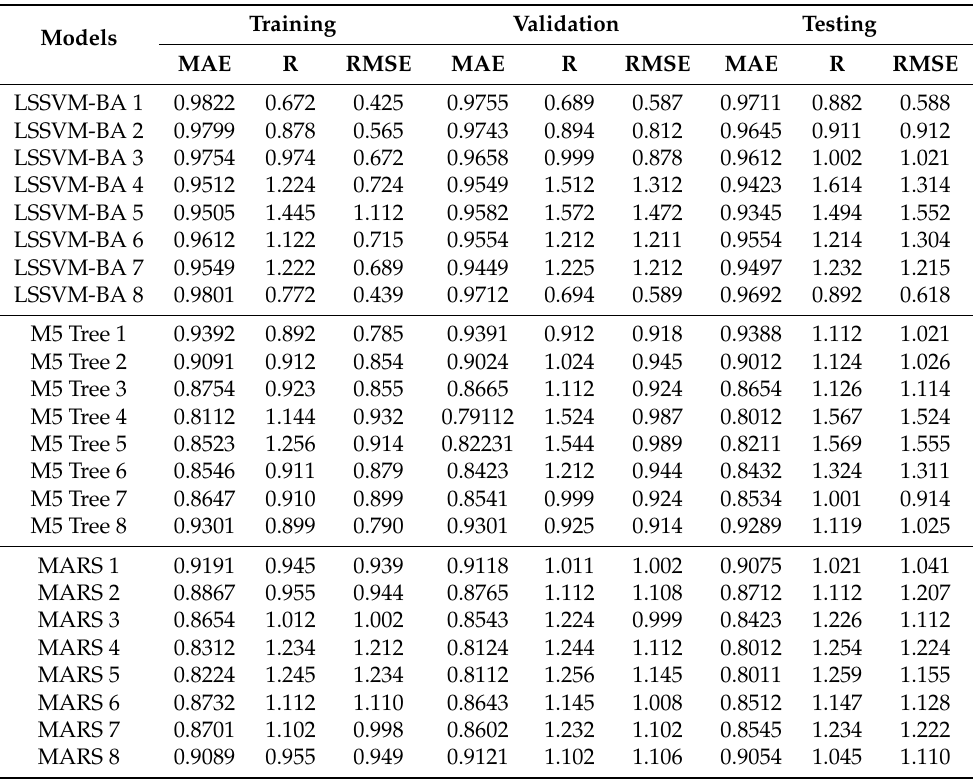
Table 6. The performance indicators of the predictive models during training/validation/testing phases at USGS